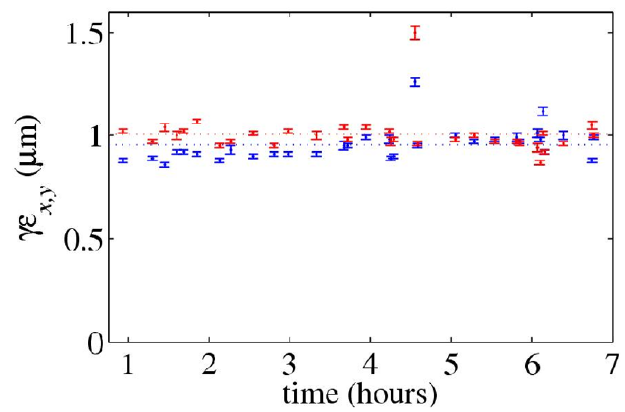
FIG. 30. (Color) Horizontal (blue) and vertical (red) projected emittance at 0.7 nC, 135 MeV, and 70 A, measured continuously over almost 8 hours. A sudden klystron error caused the spike at 4.5